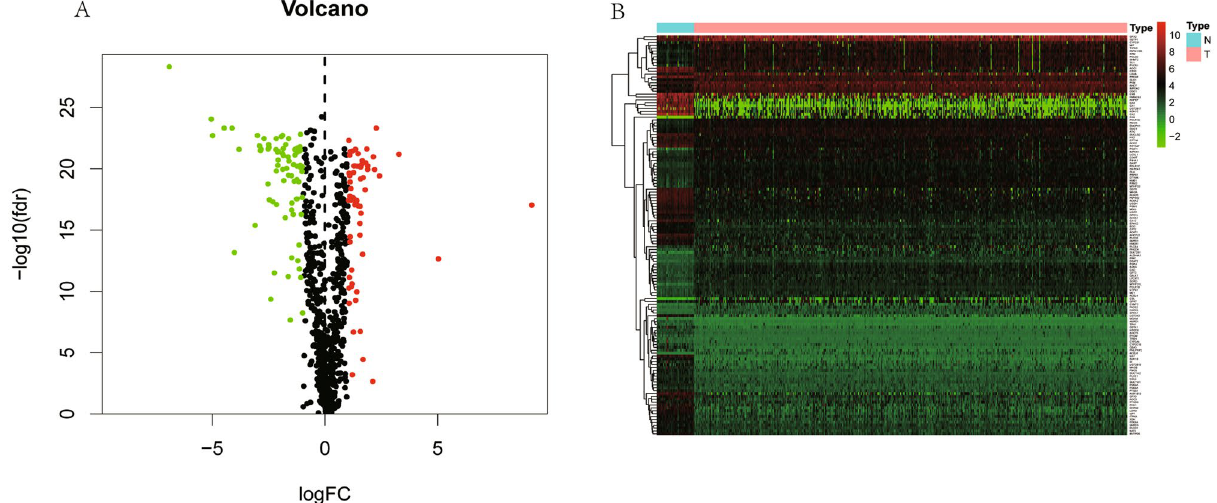
Figure 1. Volcano plot and Heatmap of differentially expressed metabolic genes. ( A ) Volcano plot of differentially expressed metabolic genes. The red points represent high expression genes, the green points represent low expression genes, the black points represent genes with no significant difference (FDR < 0.05, log FC > 1.0). ( B ) Heatmap of differentially expressed metabolic genes. Red indicates that the gene expression is relatively high, green indicates that the gene expression is relatively low, and black indicates no significant changes in gene expression (FDR < 0.05, absolute log FC > 1.0).